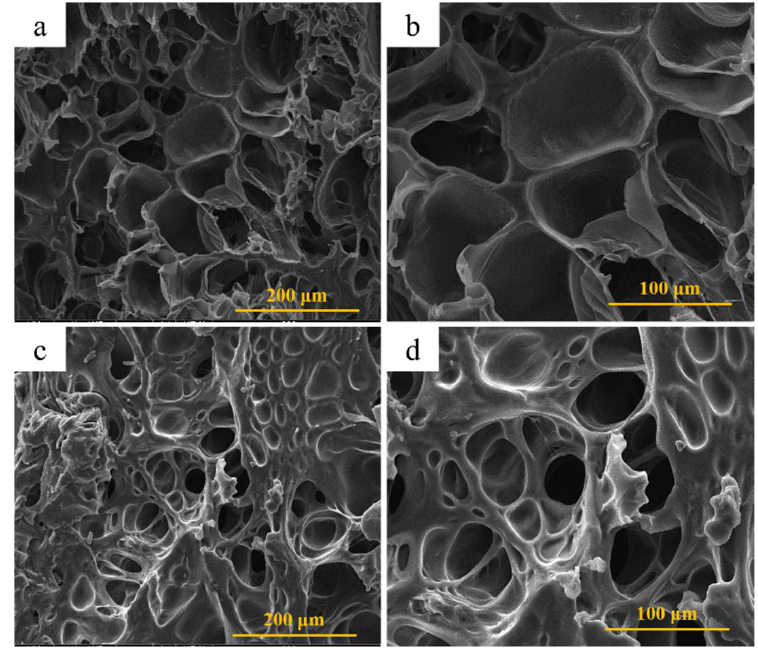
Figure 3. SEM photos of P(AMPS–co–AM) microgel ( a , b ) and p–DN hydrogel ( c , d ).